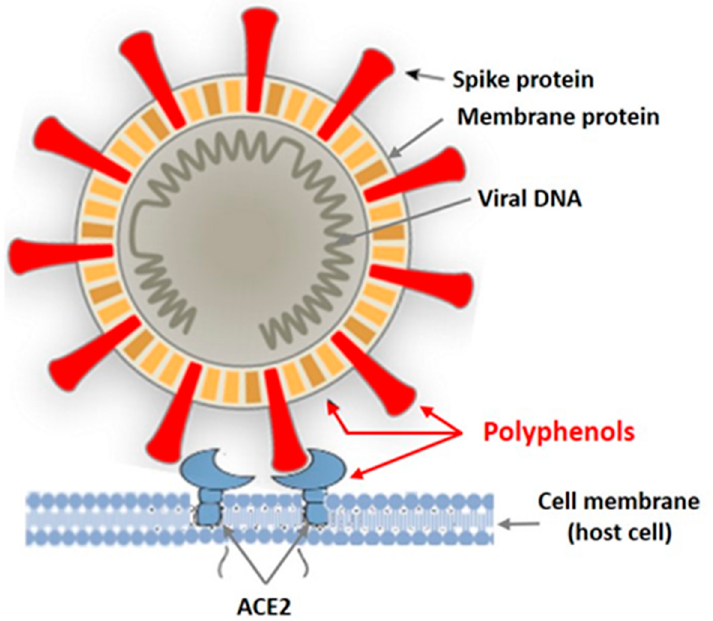
Figure 2. Targets of the enveloped virus for polyphenols of marine and terrestrial plants.